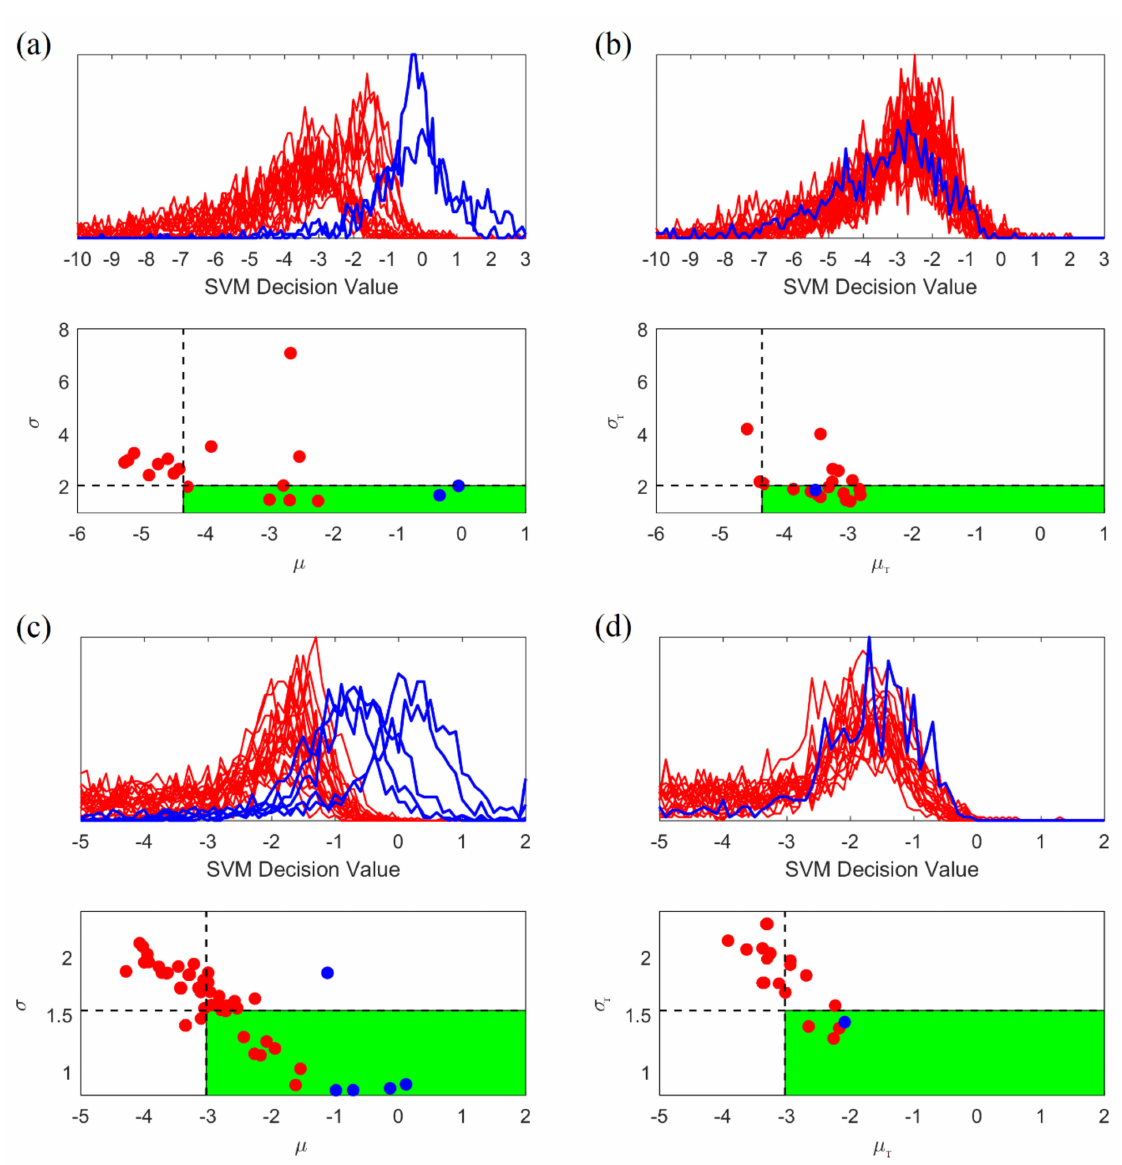
Figure 6. Histograms for 4 h iEEG segments and the corresponding bivariate decision space for discriminating between interictal (red lines/dots) and preictal (blue lines/dots) segments. Dashed lines denote thresholds, and green-shaded regions corresponds to preictal class segments. ( a ) Histograms for training data for Dog P2 (2 preictal and 16 interictal segments). ( b ) Histograms for test data for Dog P2 (1 preictal and 19 interictal segments). ( c ) Histograms for training data for Dog M3 (5 preictal and 40 interictal segments). ( d ) Histograms for test data for Dog M3 (1 preictal and 30 interictal